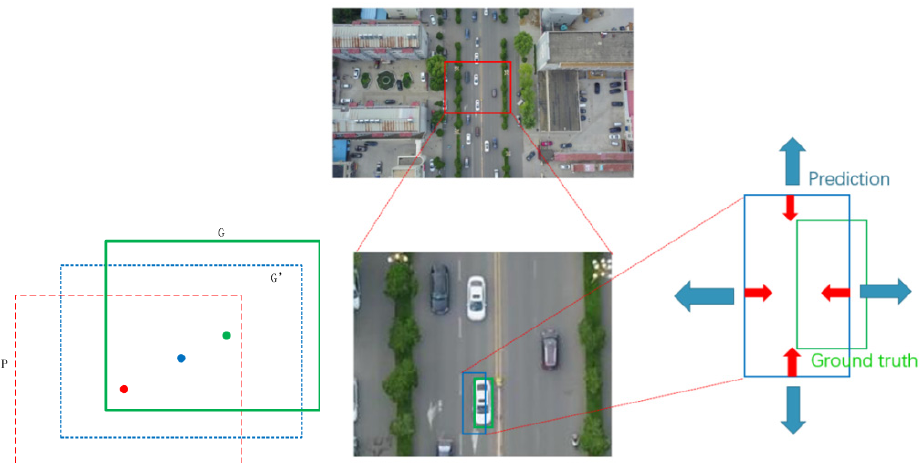
the green box G represents the ground truth real target box of the target, the red circle represents the center point of the selected candidate target box and the green circle represents the center point of the real target box. The blue circle represents the center point of the target box predicted by the selected bounding box regression algorithm. Our goal is to find a relationship so that the input original window P is mapped to a regression window G closer to the real window G (cid:48) .